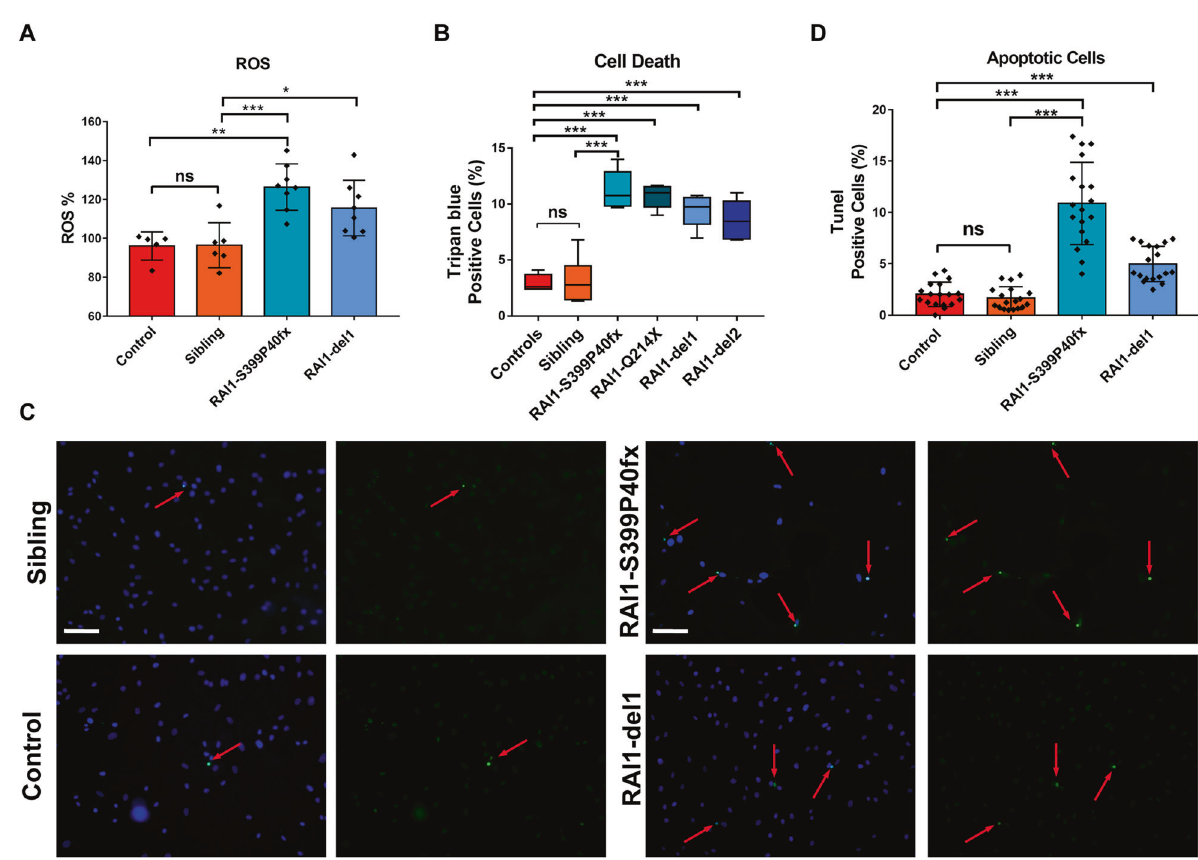
Fig. 7 Loss of RAI1 results in increased ROS production and cell death. A Quanti fi cation of reactive oxygen species (ROS) measured through an analysis of 2,7-dichlorodihydro fl uorescein diacetate (DCFDA) fl uorescence in CTR (CTR1 and sibling) and SMS (RAI1-S399P40fx and RAI1- del1) cells. The data are expressed as percentages of the control values after normalization by the total protein content ( n = 5 biological replicates). B Trypan blue analysis of four CTR and four SMS cell lines 24 h after seeding ( n = 5 biological replicates). C , D TUNEL assay of CTR (CTR1 and sibling) and SMS (RAI1-S399P40fx and RAI1-del1) cells. Representative images of 100 cells from three biological replicates are shown. Graphs: mean ± SEM, unpaired t test, * p < 0.05, ** p < 0.01, *** p < and the aberrant accumulation of lysosomes inside the cytoplasm. The accumulation of TGs is consistent with the fact that RAI1 haploinsuf fi ciency is strongly associated with a tendency toward obesity in SMS patients. Importantly, SMS patients show higher levels of total cholesterol, high-density lipoprotein (HDL), low- density lipoprotein (LDL), and TGs [54]. The most widely accepted hypothesis is that RAI1 haploinsuf fi ciency causes compulsive hyperphagic behavior, which is the main cause of obesity in patients, and this aspect has been replicated in animal models of disease [2, 5, 6, 55, 56]. Our fi ndings, however, reveal an alternative and possibly coexisting scenario: SMS cells are fat and exhibit lipid deregulation driven not only by nutrient availability but also by TG accumulation in LDs. Under normal conditions, cells use TGs as a source of energy when needed. Under pathological conditions, to